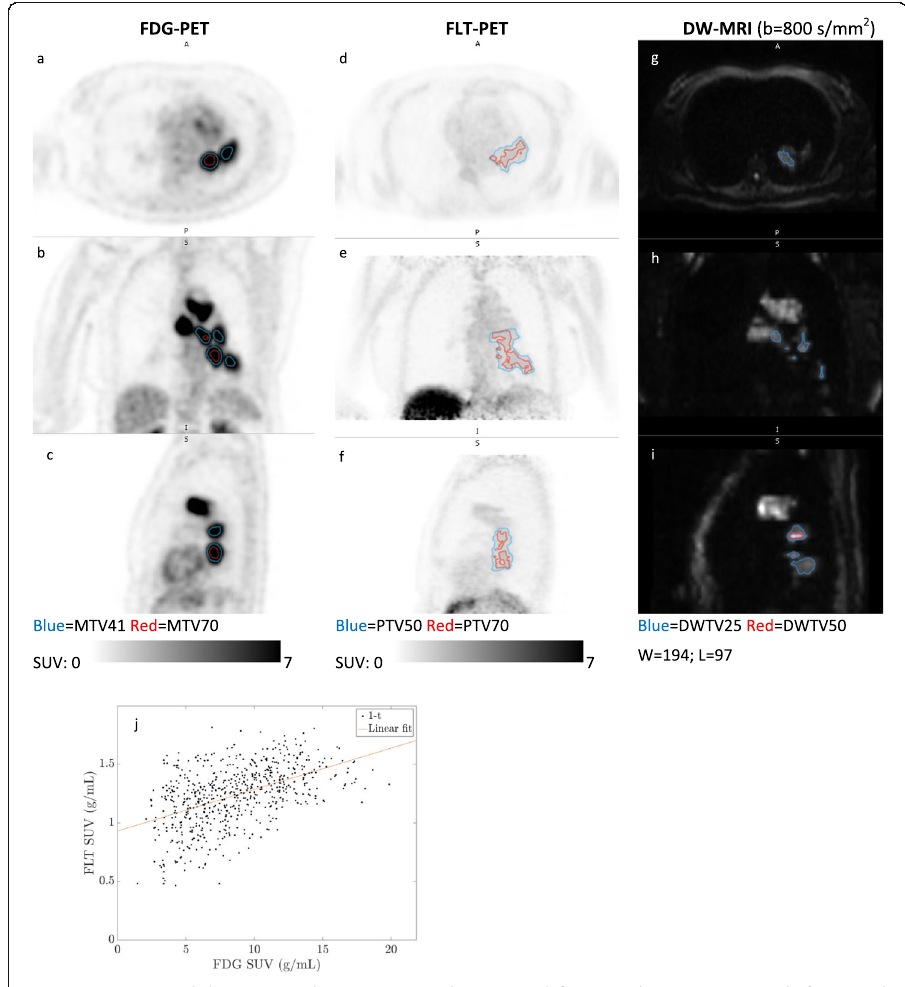
Fig. 4 T-site (1-T) with low FLT-uptake: FDG-PET (axial ( a ), coronal ( b ), sagittal ( c )), FLT-PET (axial ( d ), coronal ( e ), sagittal ( f )), and DW-MRI (transversal ( g ), coronal ( h ), sagittal ( i )), and voxel-by-voxel scatterplot of FDG- SUV vs. FLT-SUV ( j ). This T-site was clearly detectable on FDG-PET (SUV peak 16.6); almost indistinguishable from background on FLT-PET (SUV peak 1.6); and detectable on DW-MRI (ADC median 1.22 × 10 − 3 mm 2 /s). The low tumor-to-background ratio causes PTV70 to be less convincing, visually. MTV70 and DWTV50 had a partial overlap. The voxel-by-voxel scatter plot of FLT-SUV and FDG-SUV ( j ) showed an overall moderate positive correlation ( r =0.50), but the very low FLT-SUVs should be noticed, and the correlation may be a result of perfusion to the region rather than a correlation between metabolism and (a very low) proliferation. Voxel-by- voxel analysis was not feasible for FLT-SUV vs. ADC. This T-site had complete response to chemotherapy, and did not relapse during follow